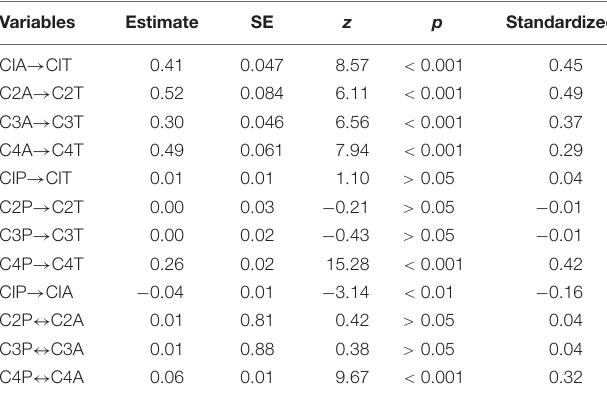
TABLE 4 | Extra dependencies in CFA model for Xandar measures.